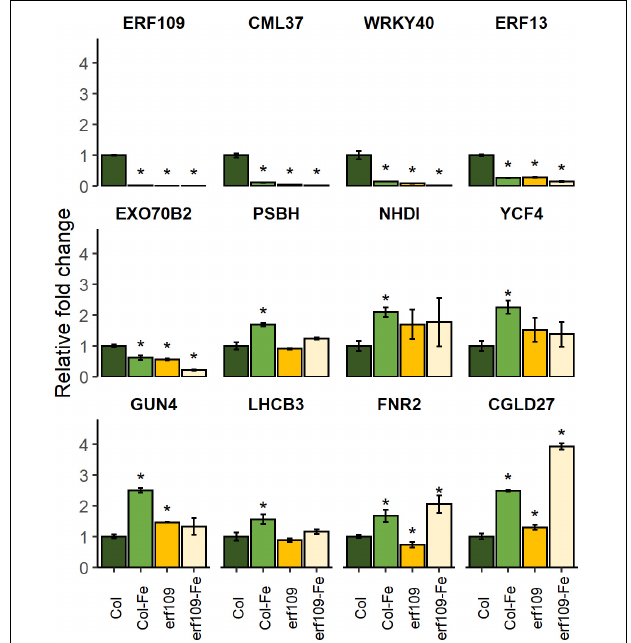
FIGURE 7 | Quantitative RT-PCR analysis of relative fold change of DEGs in Col-0 and erf109 under Fe-sufficient (Col, erf109 ) or Fe-deficient conditions (Col-Fe, erf109 -Fe). The level of transcript was normalized to Col-0 under Fe-sufficient conditions. Data are presented as mean ± SE from three biological replicates. Student’s t -test significantly different at P < 0.05 is marked with an